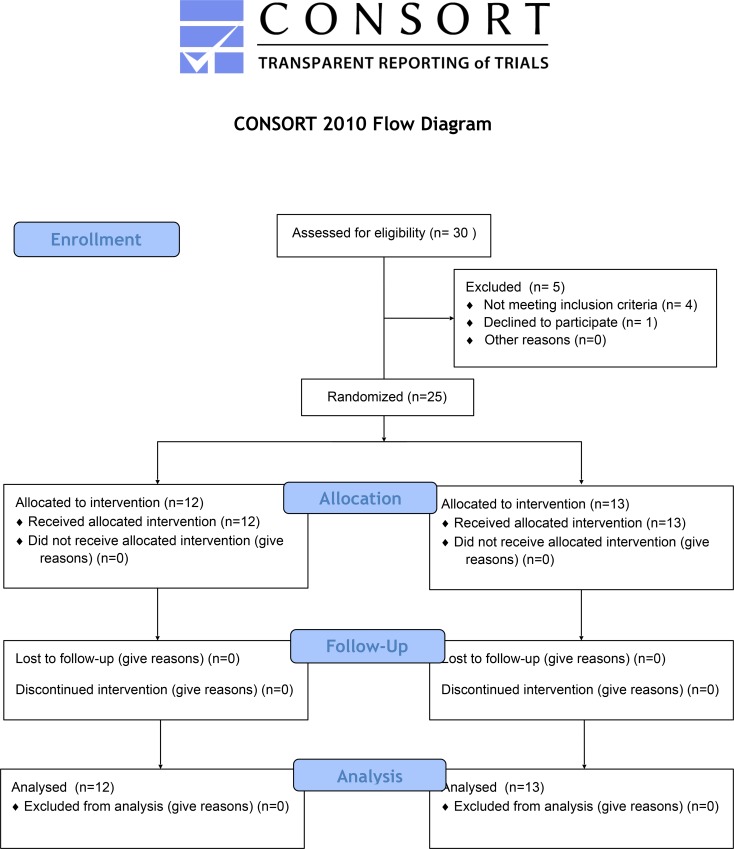
Consort diagram.